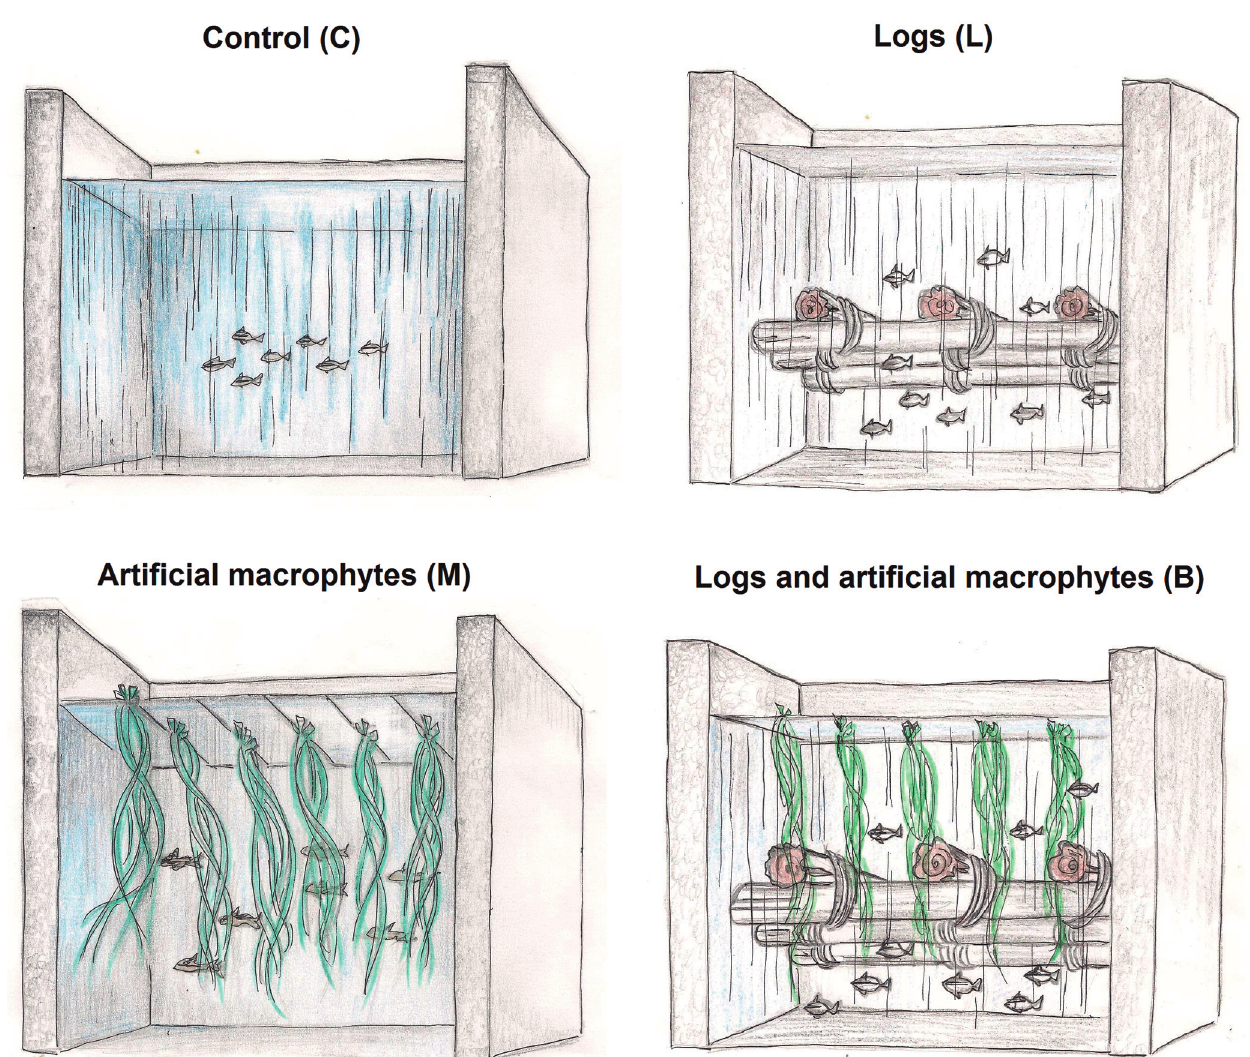
Fig. 1. Schematic drawing of the four types of structuring applied in the tanks: Control: the tank did not receive any type of structuring; Logs: the tank was structured with six eucalyptus tree logs, set in the middle of the tank so that they were submersed after the tank was filled. Three of the logs were arranged along the tank and the other three were arranged perpendicular; Artificial macrophytes: the tank received plastic macrophytes hung on a kind of clothesline placed above the tank, so that the plastic filaments came in contact with the water. Each tank received twenty five plastic macrophytes, arranged in five parallel rows of five plants each; Logs and artificial macrophytes: the tank received both types of structures, submersed logs and artificial